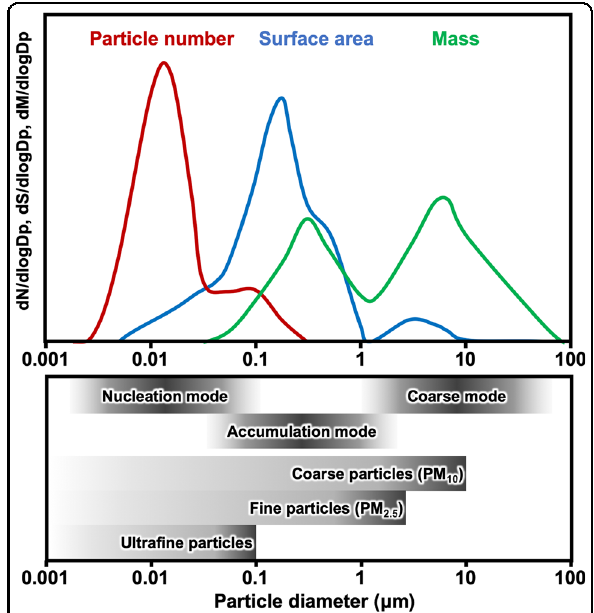
representation of a typical ambient particle-size distribution of the number concentration, surface area concentration, and mass concentration (dN/dLog Dp, particle number per cubic millimeter; dS/ dLog Dp, particle surface area per cubic millimeter; and dM/dLog Dp, particle mass per cubic millimeter, respectively) 99 . Vertical scaling is individual to each distribution. There are three modes of atmospheric aerosol particles: nucleation mode, accumulation mode, and coarse mode. Ultra fi ne particles (UFPs) are all particles with a diameter of 100nm or less. Most nucleation mode particles and the fraction of accumulation mode particles are